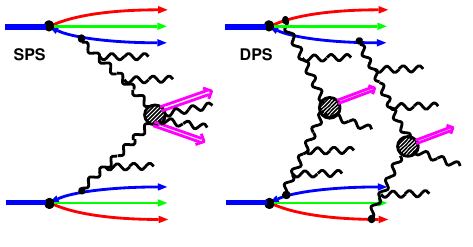
Figure 1. SPS (left) and DPS (right) production mechanisms of a quarkonium